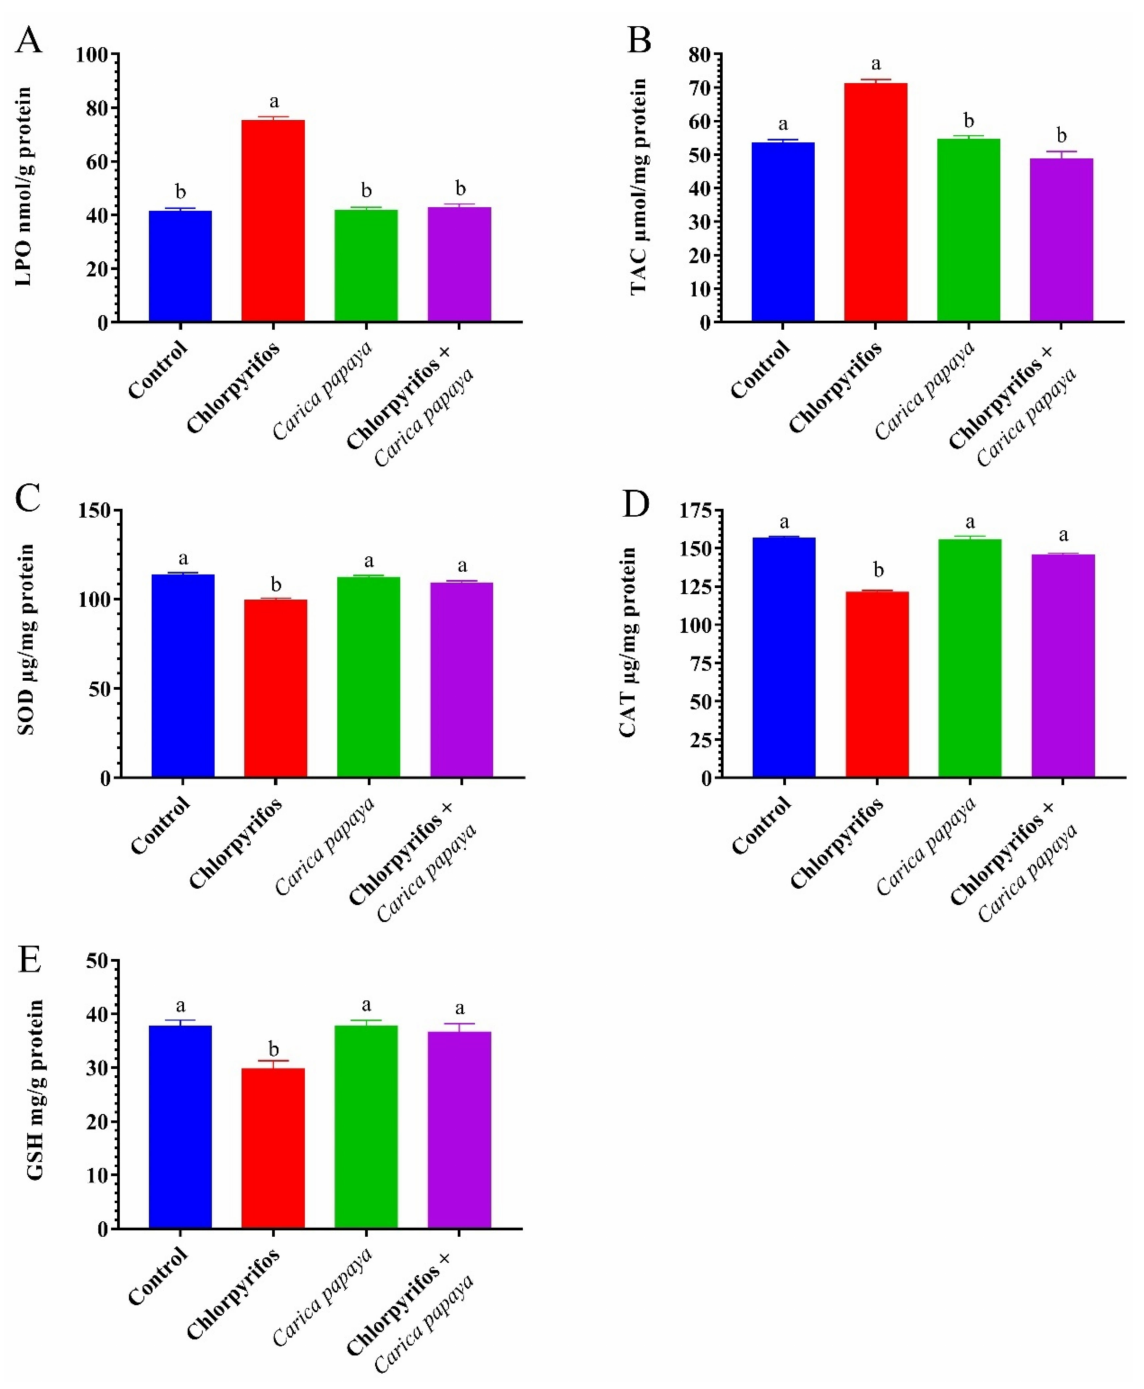
Figure 1. Lipid peroxidation ( A ), total antioxidant capacity ( B ), superoxide dismutase ( C ), total antioxidant capacity ( D ), catalase ( D ), and reduced glutathione ( E ) of hepatopancreas tissue in female African catfish, Clarias gariepinus , exposed to chlorpyrifos (8.75 µ g/L.) and co-administrated with papaya, Carica papaya , aqueous extract (250 mg/kg body weight) for 6 weeks. The column bearing with different letters are significantly different ( p <